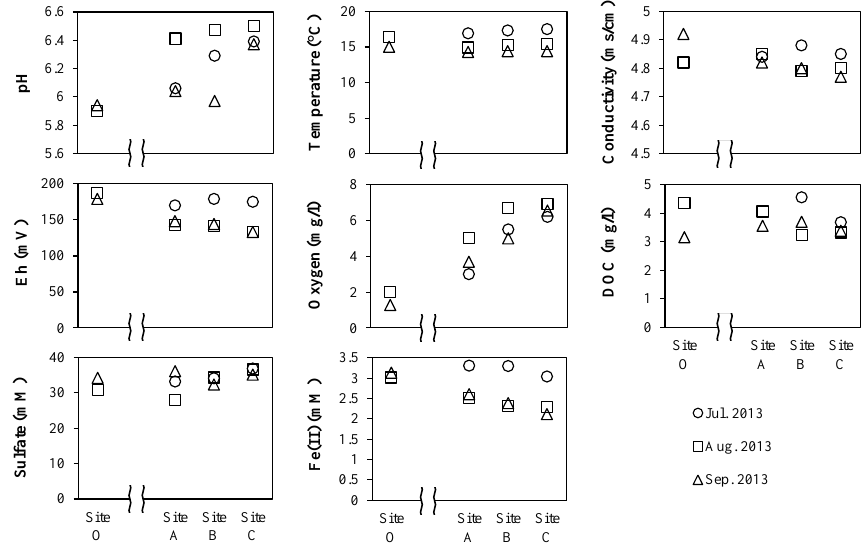
Figure 2. Chemical parameters of water at each sampling site in the outflow water stream. Water pH, oxygen, temperature, conductivity, and Eh were measured in the field at site O, A, B, and C in July, August, and September 2013. Concentrations of organic carbon, sulfate, and Fe(II) were determined later in the laboratory.